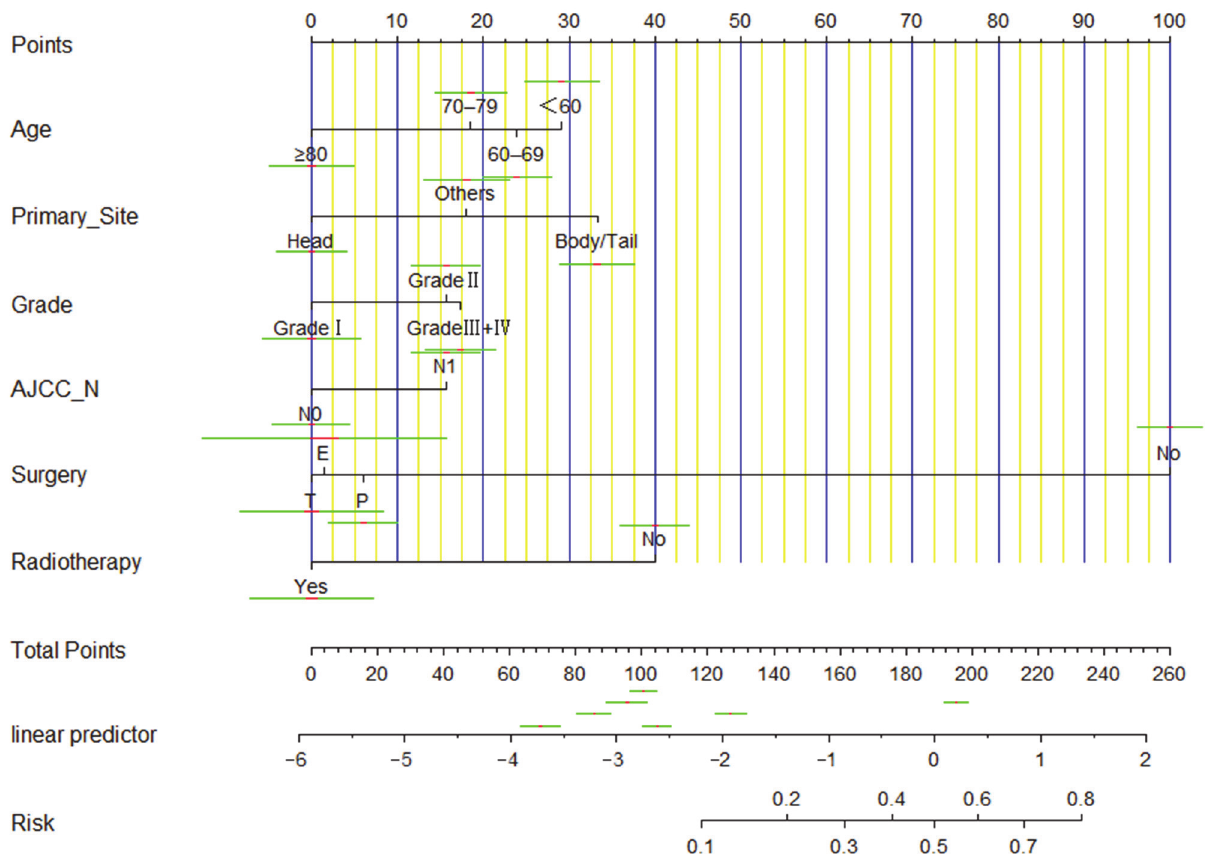
Figure 3. Nomogram to predict distant metastasis of PDAC. Others: including pancreatic duct, islets of Langerhans, other specified parts of pancreas, overlapping lesion of pancreas. T: total pancreatectomy; E: extended pancreatectomy; P: partial pancreatectomy.